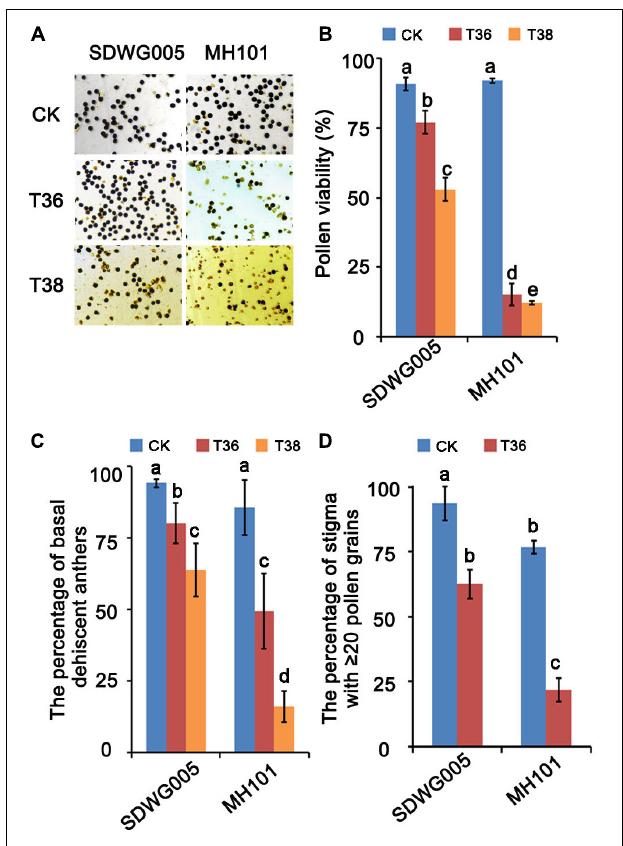
FIGURE 1 | Effect of heat stress on pollen viability and pollination properties of SDWG005 and MH101. (A,B) Differences in pollen viability of SDWG005 (heat-tolerant) and MH101 (heat-susceptible) exposed eight days to different temperature treatments. (C) The percentage of basal dehiscent anthers under high-temperature treatments. (D) The percentage of stigma with ≥ 20 pollen grains at anthesis. CK, T36 and T38 indicate normal temperature ( T max = 28 ◦ C) and high temperatures T36 ( T max = 36 ◦ C) and T38 ( T max = 38 ◦ C). Each data point represents the mean ± SD ( n = 3) of three biological replicates. Significant differences are calculated by One-way ANOVA with Duncan’s multiple test (SAS Institute, Inc., Cary, NC, United States). Different letters indicate statistical differences between samples at P =